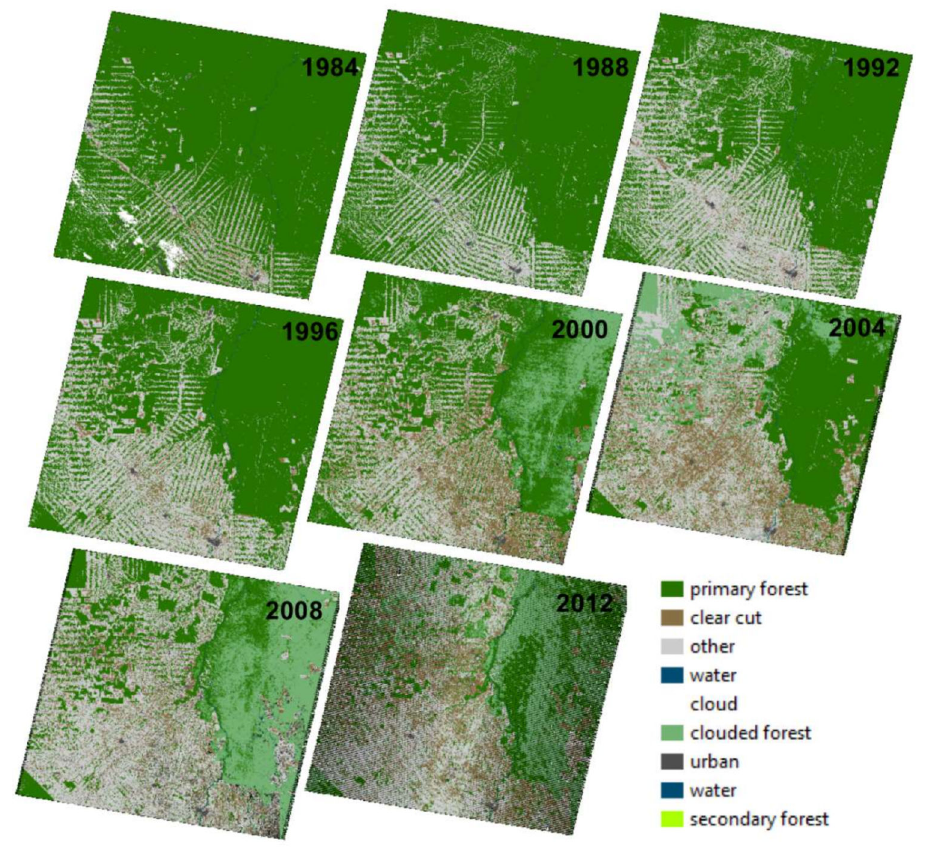
Figure 3. “Fishbone” road development pattern in Amazonia using Landsat TM data over 28 years. We used land surface reflectance Landsat data and classified it with maximum likelihood algorithm to distinguish the nine most dominant classes in the scene., with classification accuracies of 0.92 ± 0.05, and kappa coefficient 0.85 ± 0.08. Most misclassification occurred for secondary forest, but this is beyond the point of this figure as we use it to illustrate development of the fish-bone pattern over time. In the 2012 image the stripes correspond to the failure in the Scan Line Corrector of Landsat 7 and these were the only ones available for this year (figure from